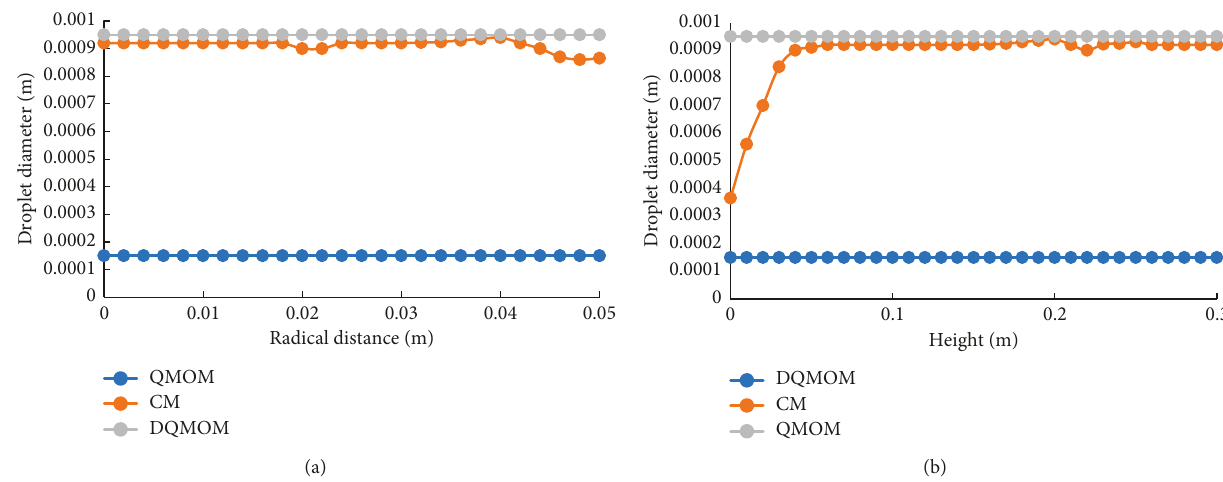
Figure 3: Droplet Sauter diameter distribution along (a) the radical distance ( h � 0.2 m) and (b) the height in the extractor.